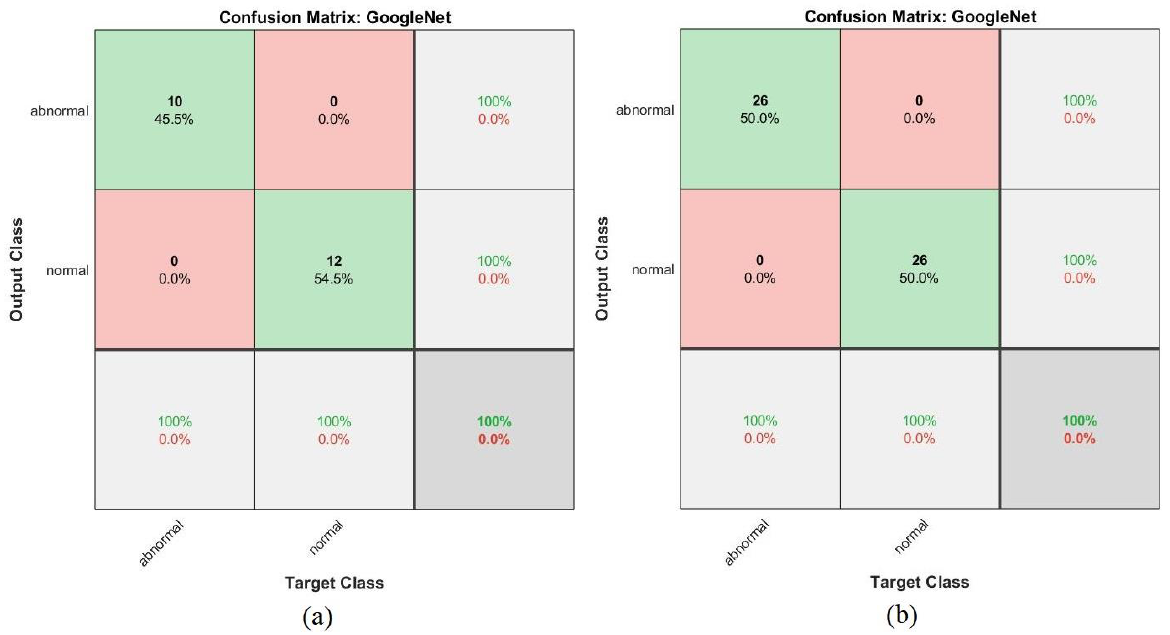
Figure 22. Confusion matrix for the AlexNet model for the ( a ) ALL_IDB1 and ( b ) ALL_IDB2 da- tasets.